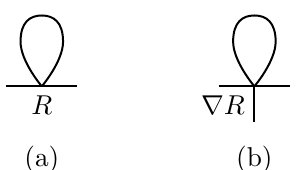
Figure 2 . (a) The one-loop contribution to the propagator. (b) The one-loop contribution to the 1PI three-point